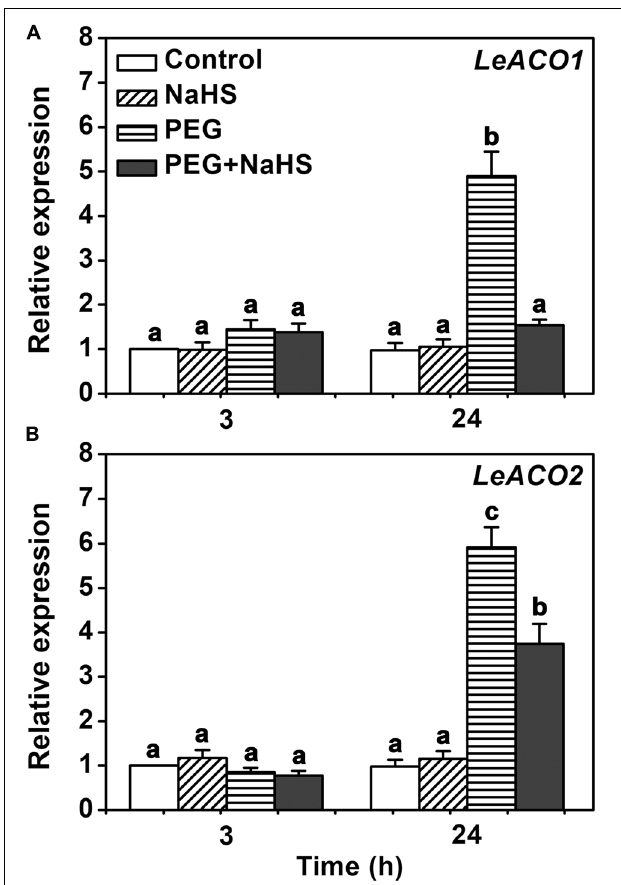
FIGURE 6 | The expressions of LeACO1 and LeACO2 genes analysis in leaves. (A) Relative expression of LeACO1 . (B) Relative expression of LeACO2 . Two-week-old tomato seedlings were supplied with 25 % PEG, 200 µ M NaHS and 1.0 g/L Ethephon for 3 h or 24 h, and qRT-PCR used for gene expression analysis. Within each set of experiments, bars with different letters are significant different (Duncan’s multiple range tests, P < 0.05).